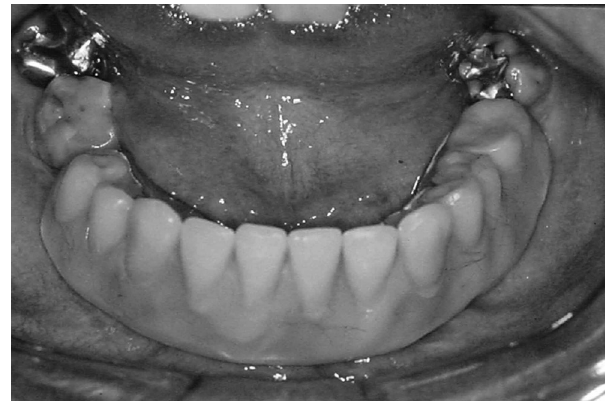
Figure 9 - An intraoral ten-years postoperative view showing an implant- supported denture over a health attached alveolar mucosa